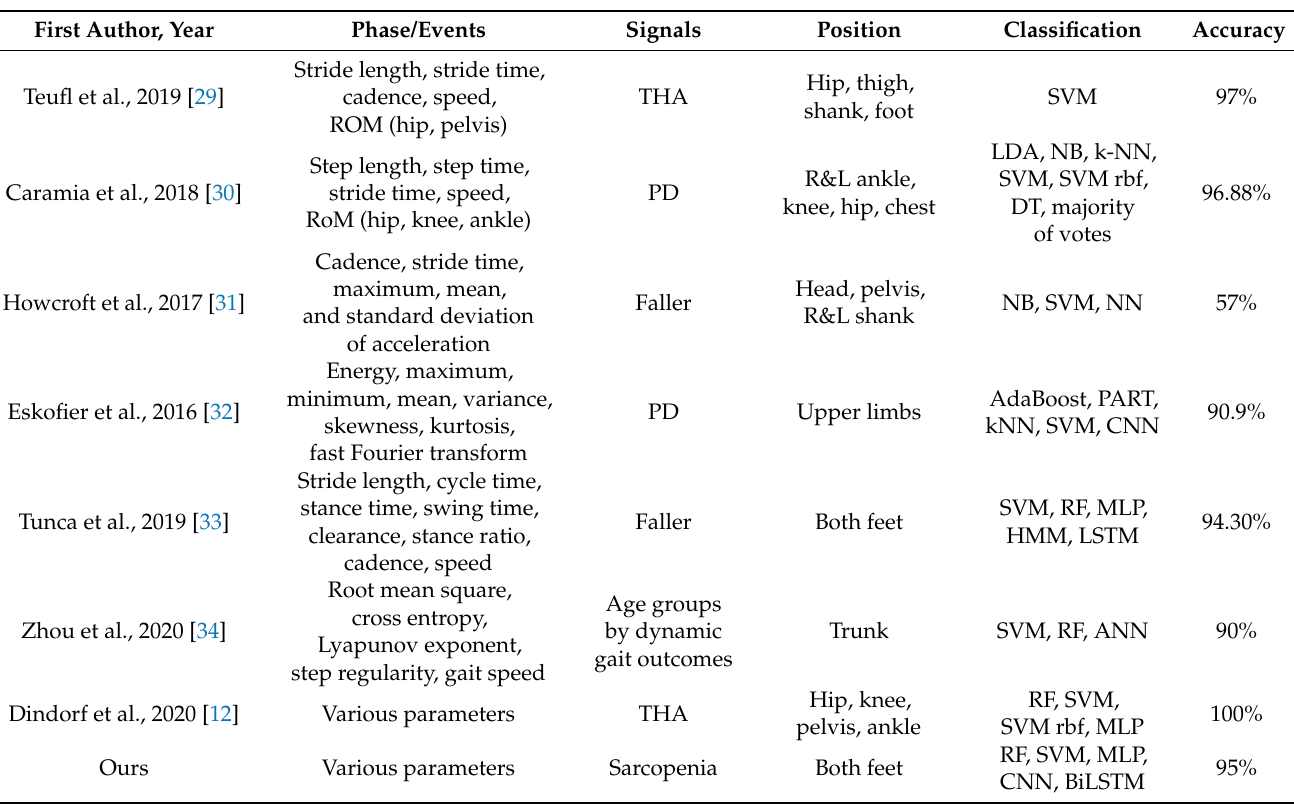
Table 2. Existing studies on disease identification using gait parameters.